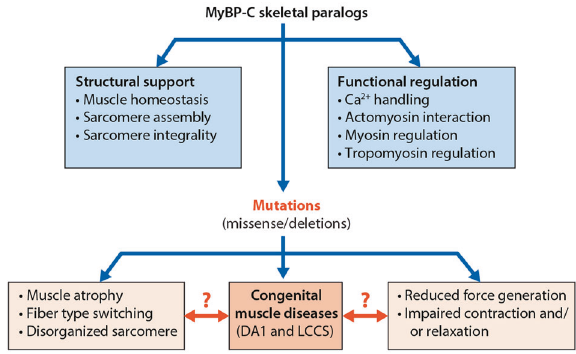
Fig. 4 Schematic diagram of two major functions of skeletal MyBP-C protein and pathogenic consequences by their deletion and